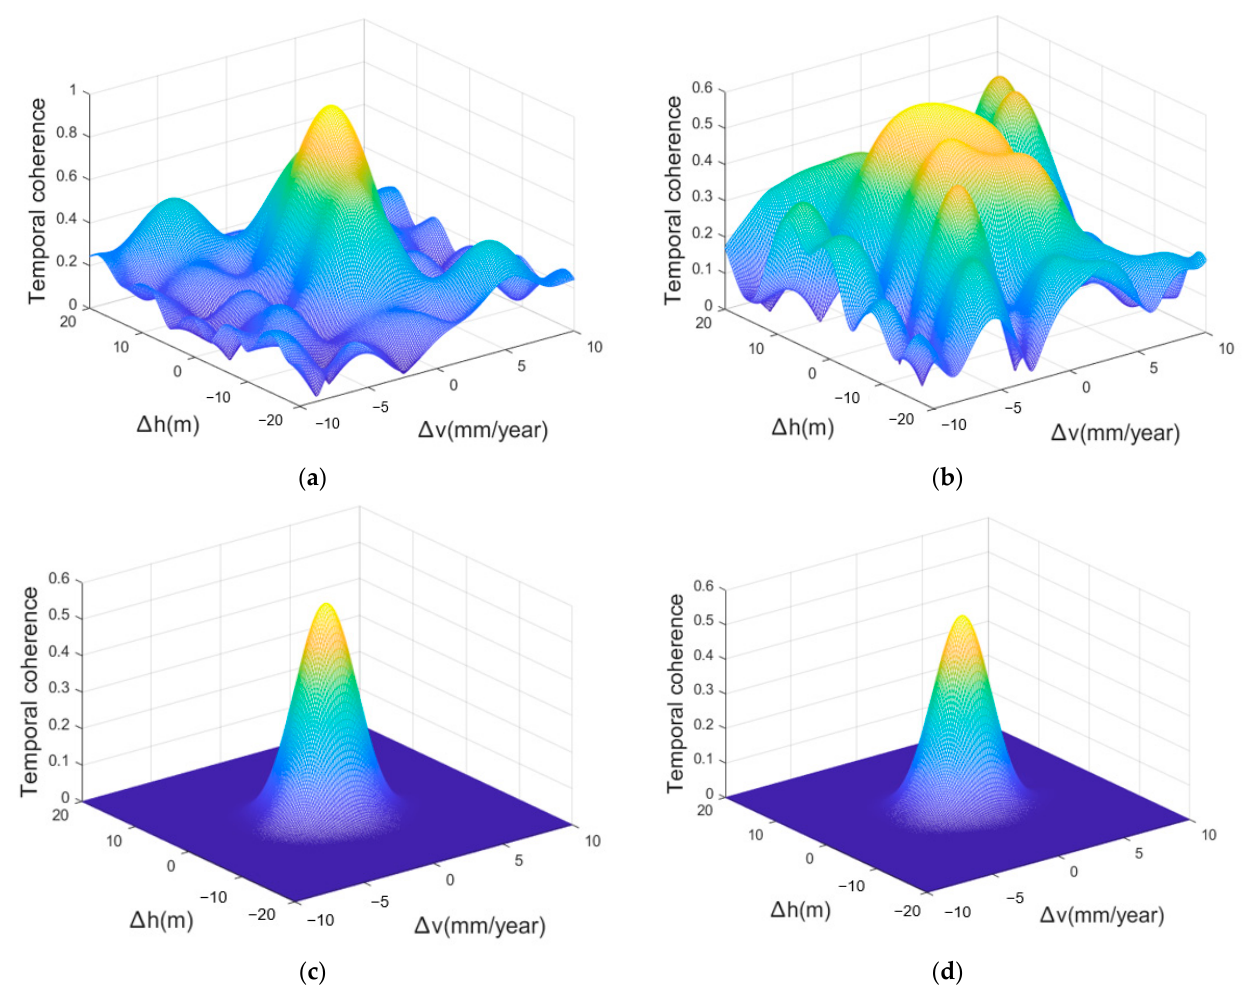
Figure 2. Estimation of ∆ h and ∆ v : ( a ) MLE without noise: γ MTC = 1, ∆ h = 0, ∆ v = 0; ( b ) MLE with noise: γ MTC = 0.6, ∆ ˆ h = 2.8, ∆ ˆ v = − 1.4; ( c ) MAP estimation with noise: ∆ ˆ h = 0.2, ∆ ˆ v = 0 and unbiased prior: ∆ h ~N(0,9), ∆ v ~N(0,4); ( d ) MAP estimation with noise: ∆ ˆ h = 0.8, ∆ ˆ v = 0.6 and biased prior: ∆ℎ~N(1,9), ∆𝑣~N(1,4) .